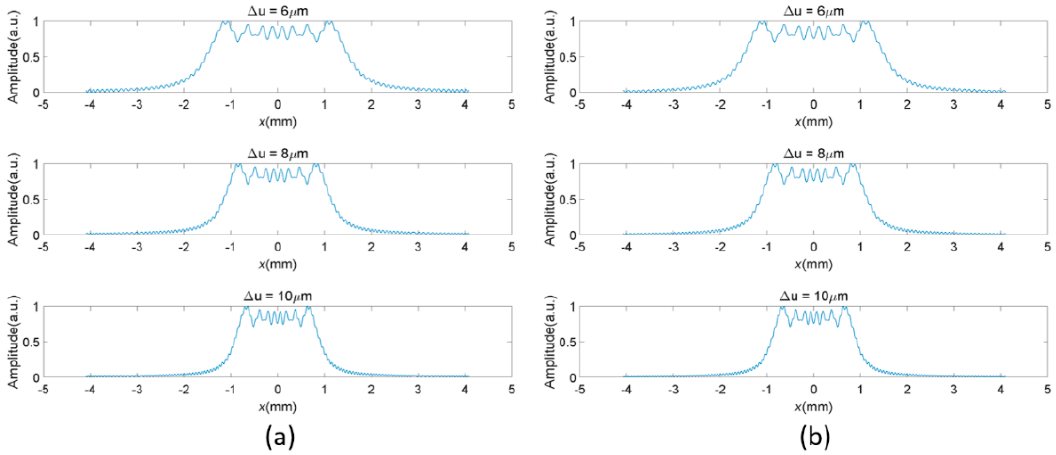
Figure 8. Amplitude profiles of the diffraction fields at different propagation distances: ( a ) Shifted Fresnel diffraction, ( b ) Rayleigh–Sommerfeld diffraction integral.